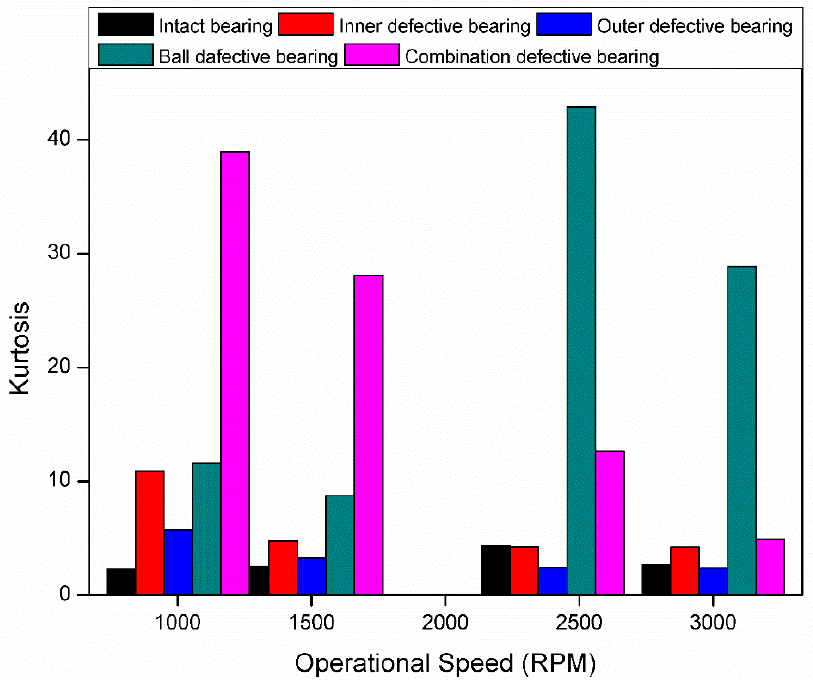
Figure 10. Comparison of averaged kurtosis values without installing a bearing loader.